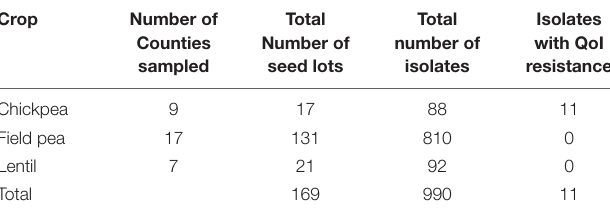
TABLE 5 | Distribution of Ascochyta isolates collected per crop in 2014–2016 from